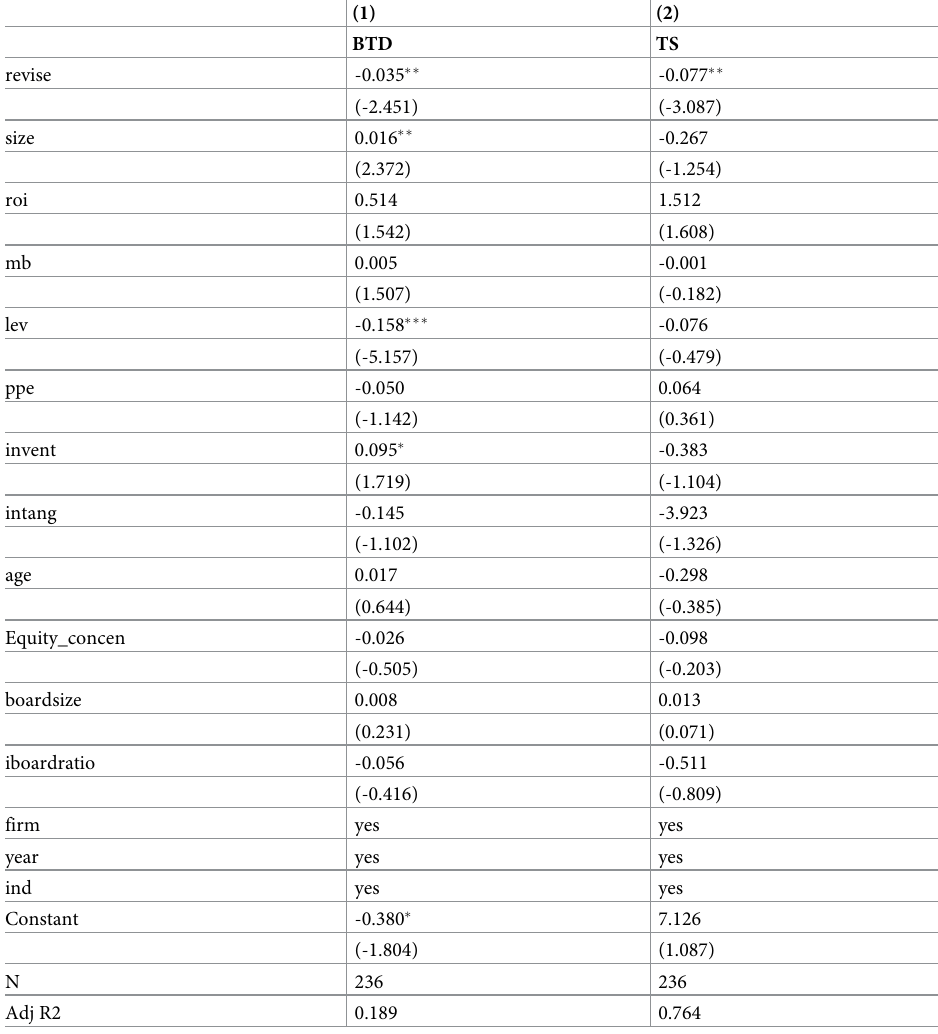
Table 12. Impact of revising accounting